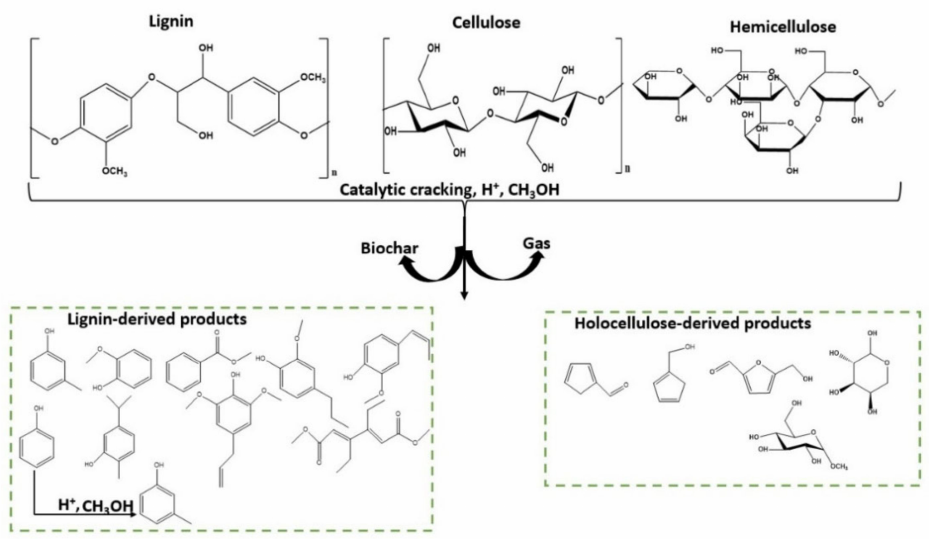
Figure 11. The possible reaction pathways for conversion of date palm waste into high value